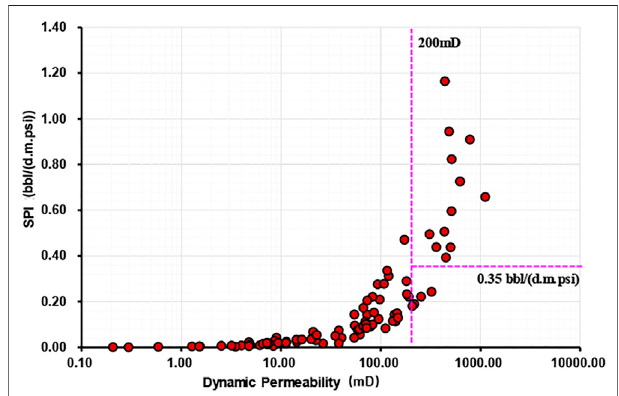
FIGURE 9 | Comprehensive histogram of P2